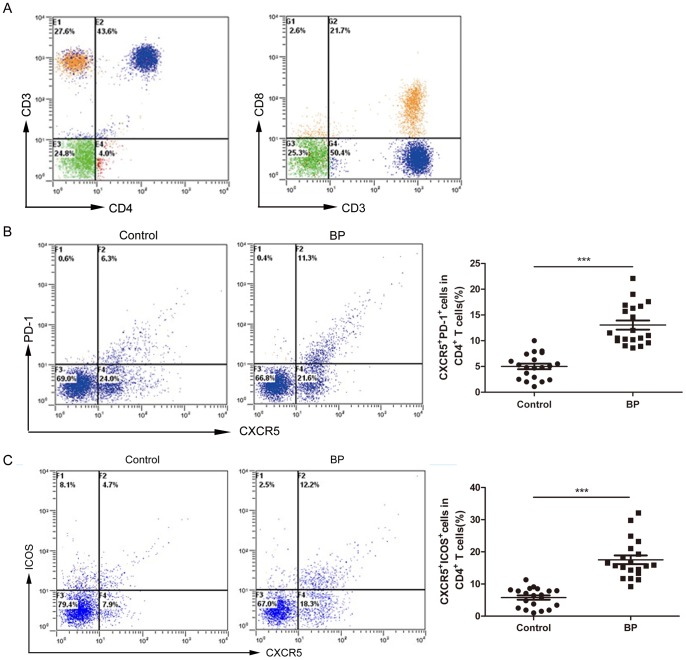
The proportion of Tfh cells in the peripheral blood of BP patients.(A) Upper right quadrant: percentages of CD3+CD4+ and CD3+CD8+ cells (43.6% and 21.7%, respectively); these agreed with previous results. (B) The percentages of CXCR5+PD-1+ cells among the CD4+ T lymphocytes of 20 BP patients and 20 healthy controls. (C) The percentages of CXCR5+ICOS+ cells among the CD4+ T lymphocytes of 20 BP patients and 20 healthy controls. Each data point represents an individual subject. ***P<0.001.